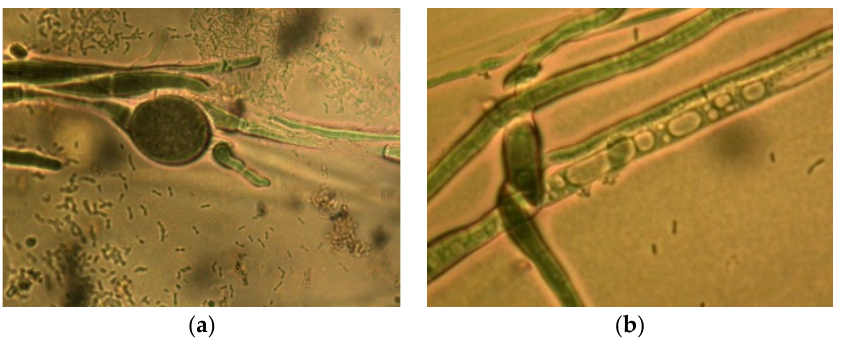
Figure 4. Pathological changes in F. graminearum BZR 4: cells of the chlamydospore type ( a ), vacu- olization of the hyphae contents ( b ), magnification ×400.